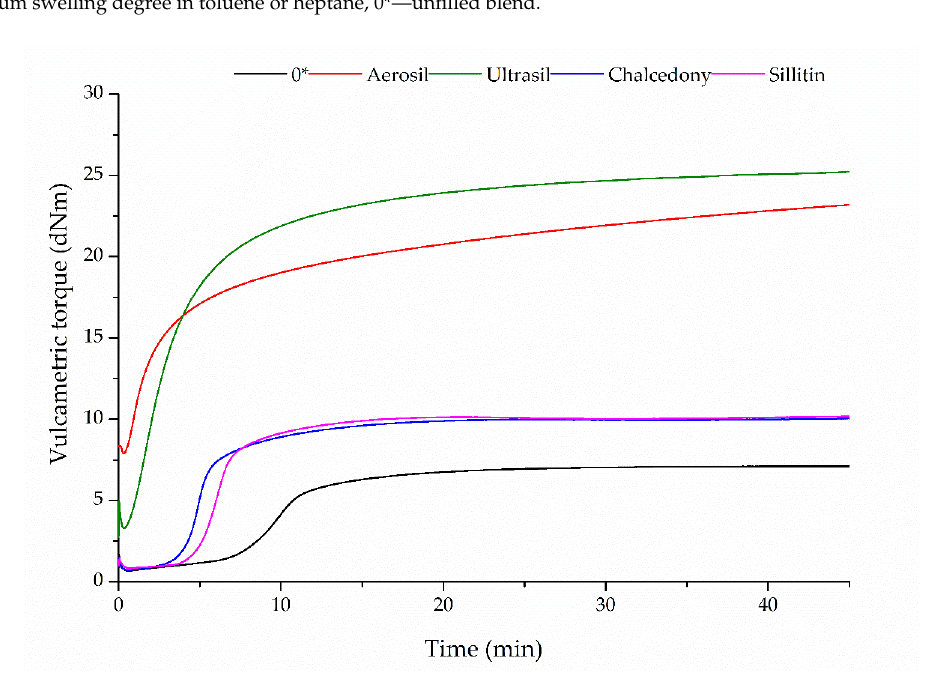
Figure 5. The rheometric curves of unfilled and filled CR/BR/nano-Fe 2 O 3 blends. The use of nano-iron(III) oxide as a crosslinking agent of CR/BR blends, probably leads to the formation of an interelastomeric bond between the tested rubbers. The pro- posed crosslinking mechanism of the CR/BR composites in the presence of iron(III) oxide nanoparticles is shown in Scheme